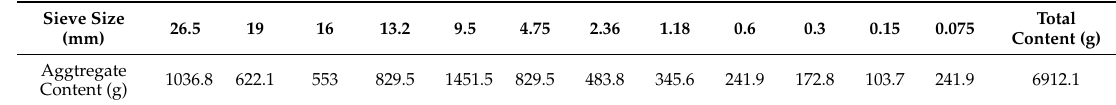
Table 2. The aggregate content of cylinder specimen.